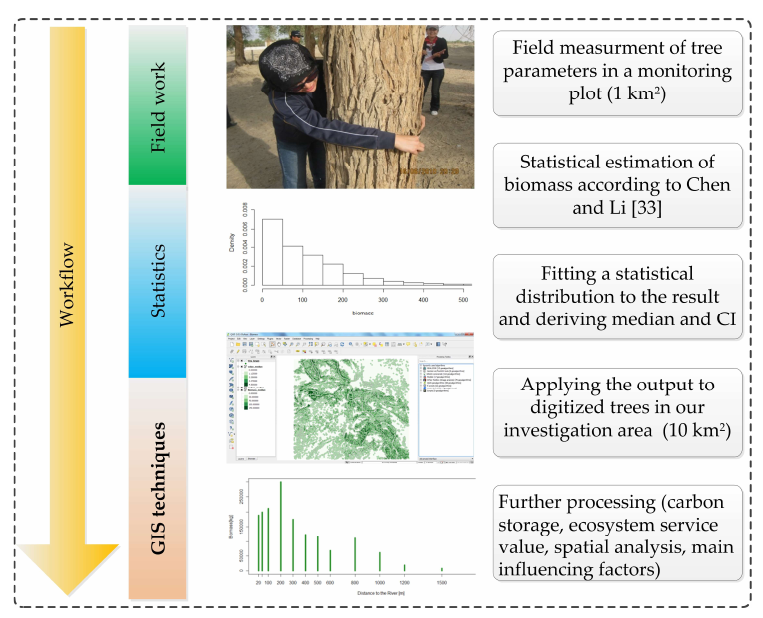
Figure 3. The workflow of this study (CI indicates confidence interval, GIS techniques refers to some of geographical information system tools such as digitization used in this study).